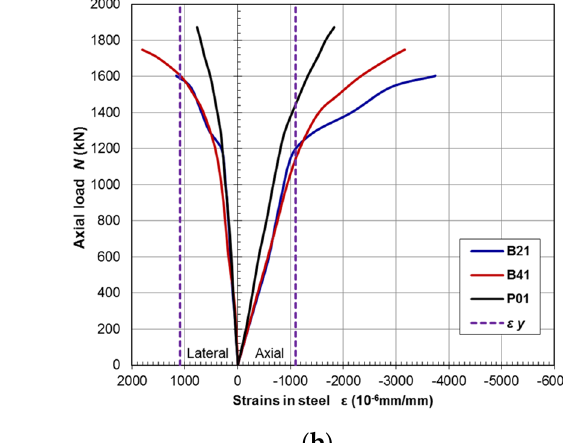
Figure 14. Comparative relationships of load versus strains on test specimens. Registered strains on concrete ( a ) and on steel jacket ( b ).